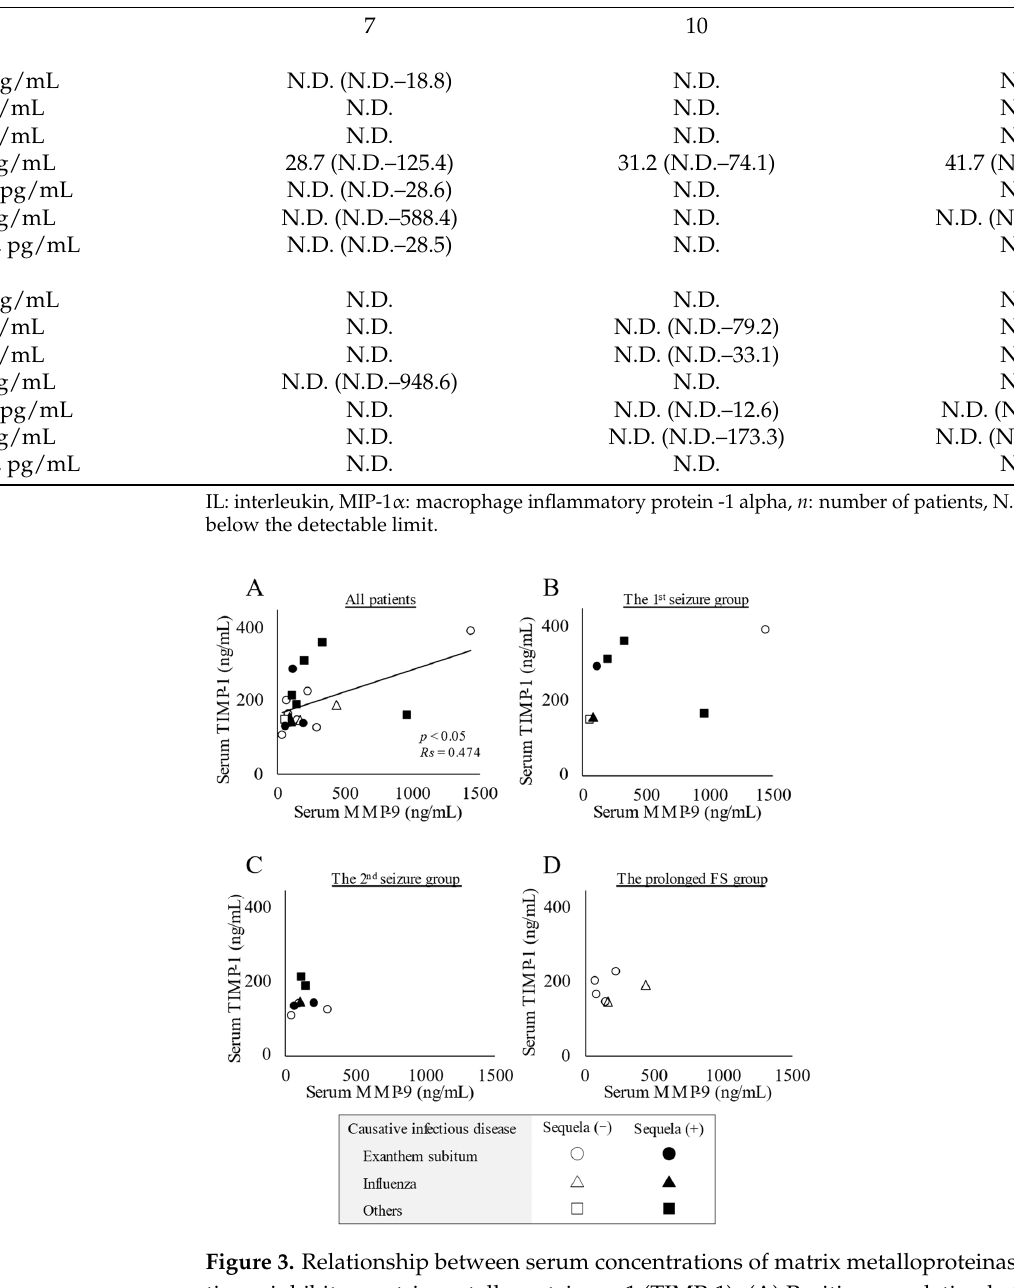
Table 2. Serum and cerebrospinal fluid (CSF) cytokine profiles in patients with acute encephalopathy with biphasic seizures and late reduced diffusion (AESD) or prolonged febrile seizure (FS). AESD Prolonged FS Group 2nd Seizure Phase Group Median (Range) or Number1st Seizure Phase Group Median (Range) or Number Median (Range) or Number